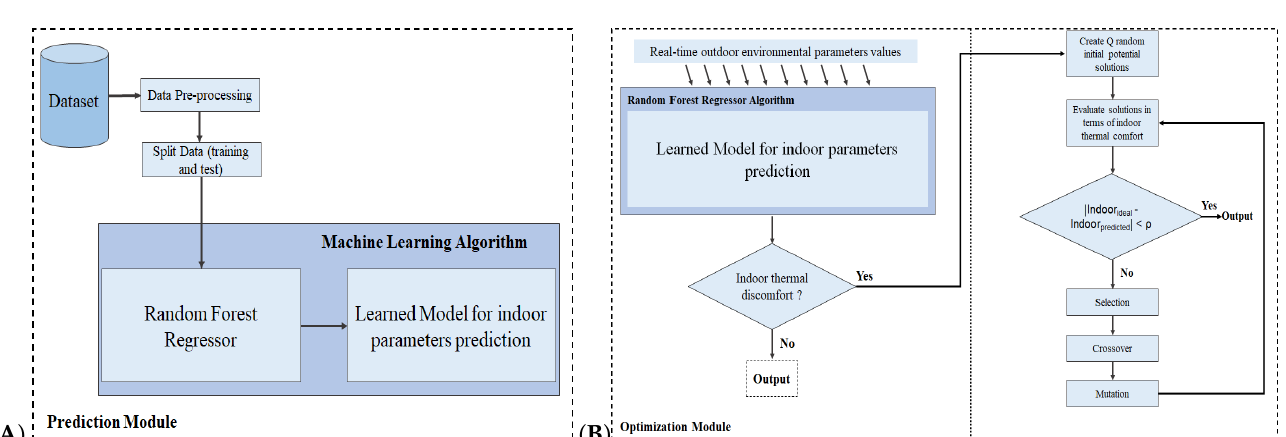
Figure 3. Our modules of indoor parameters assessment. ( A ) Indoor parameters prediction module. ( B ) Indoor parameters optimization